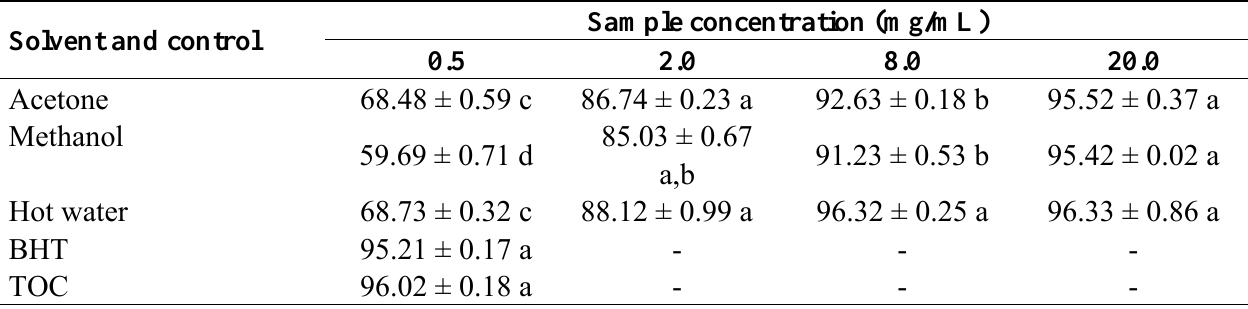
Table 1. Antioxidant activity against β -carotene-linoleic acid of different concentrations of various extracts from the fruiting bodies of Lentinus lepideus